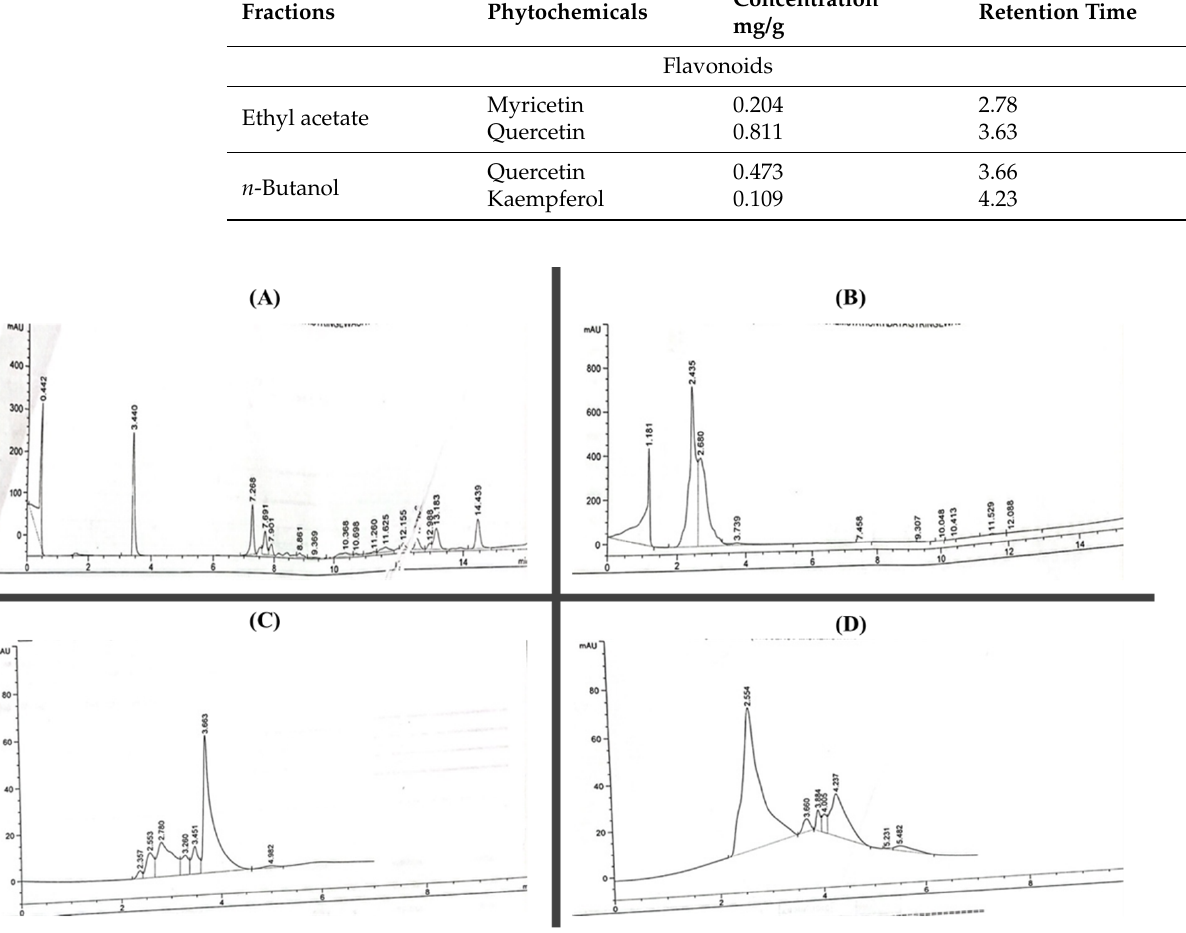
Figure 2. Chromatogram of phenolics and flavonoids of fractions of T. vulgaris. ( A ) Phenolics of ethyl acetate, ( B ) phenolic of n -butanol, ( C ) flavonoids of ethyl acetate, and ( D ) flavonoids of n -butanol.